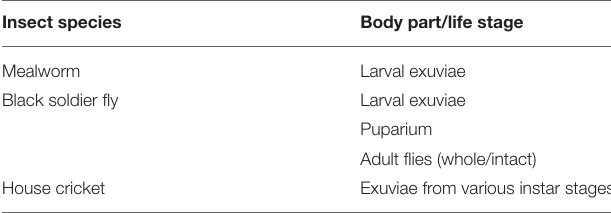
Puparium Adult flies (whole/intact)